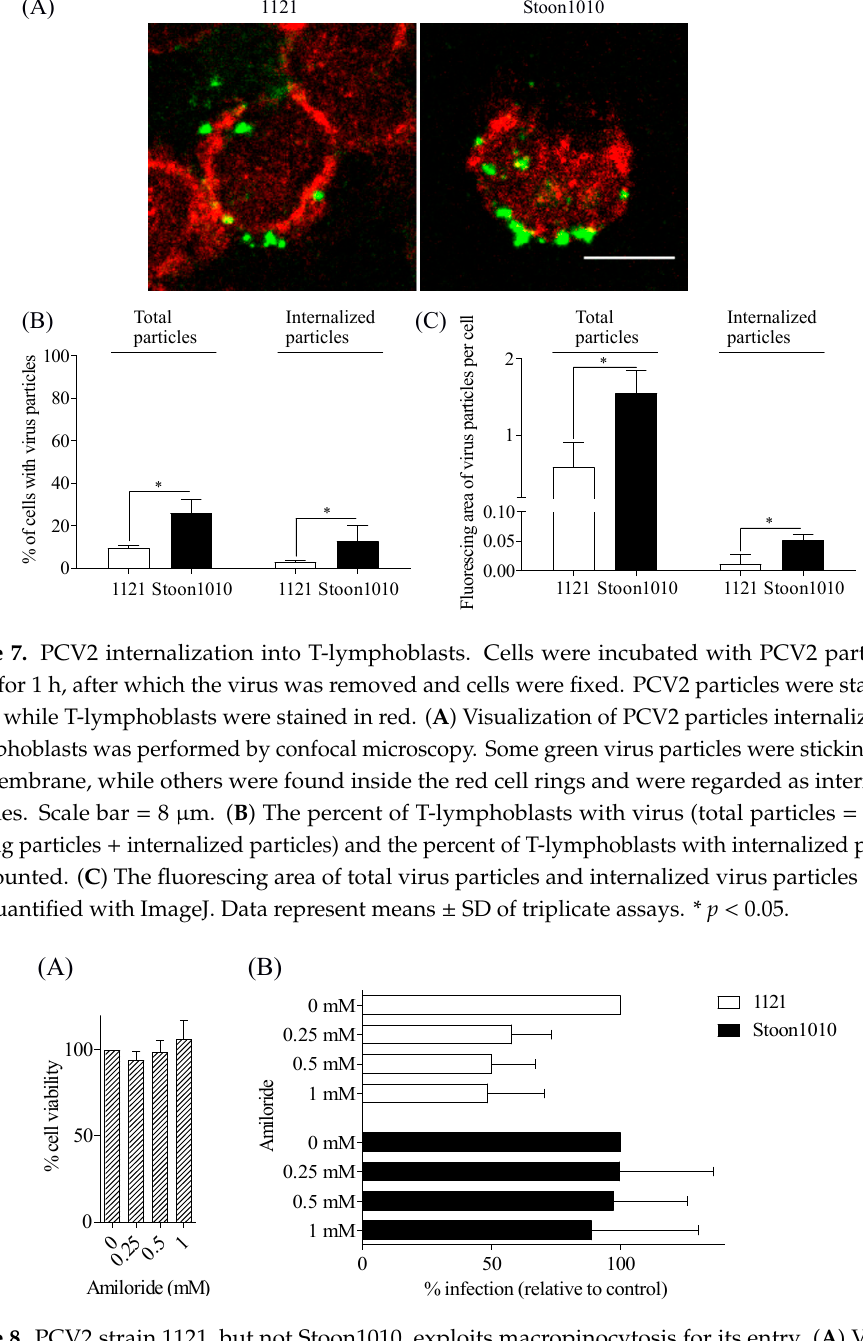
Figure 8. PCV2 strain 1121, but not Stoon1010, exploits macropinocytosis for its entry. ( A ) Viability of cells treated with di ff erent concentrations of amiloride, as measured by MTT assay. ( B ) Cells were pre-treated with amiloride (0, 0.25, 0.5, 1 mM) prior to PCV2 infection. The percentage of PCV2-infected cells was quantified. The infection level in the treated group was expressed as the relative percentage to that of the control group (drug concentration = 0 mM). Data represent means ± SD of triplicate